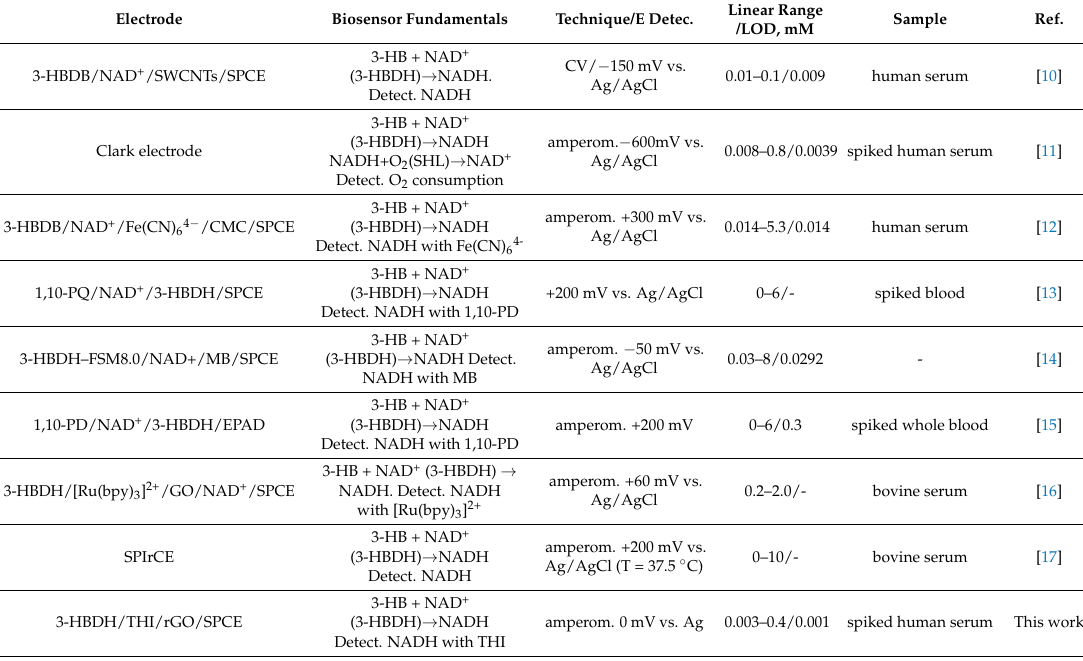
Table 1. Some electrochemical enzyme biosensors for the determination of 3HB.